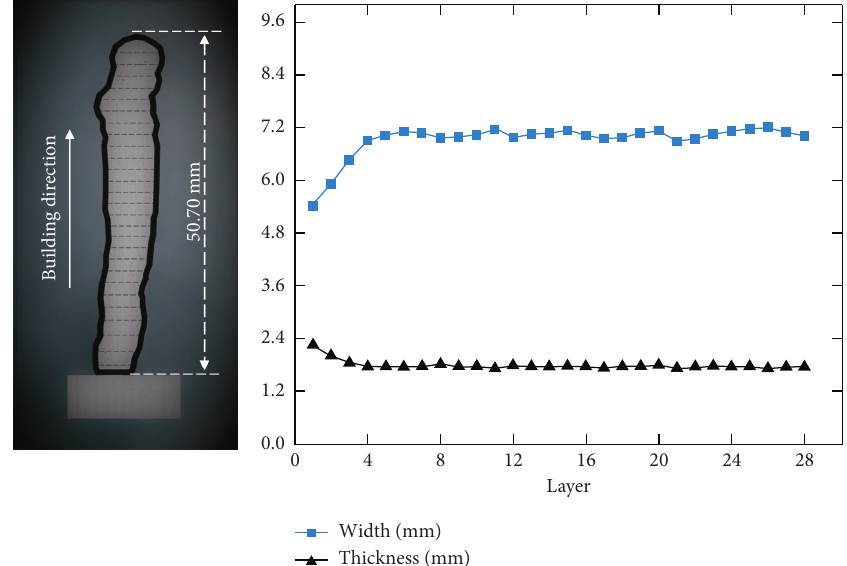
Figure 4: Layer width and thickness of the deposition wall without the path constraint.